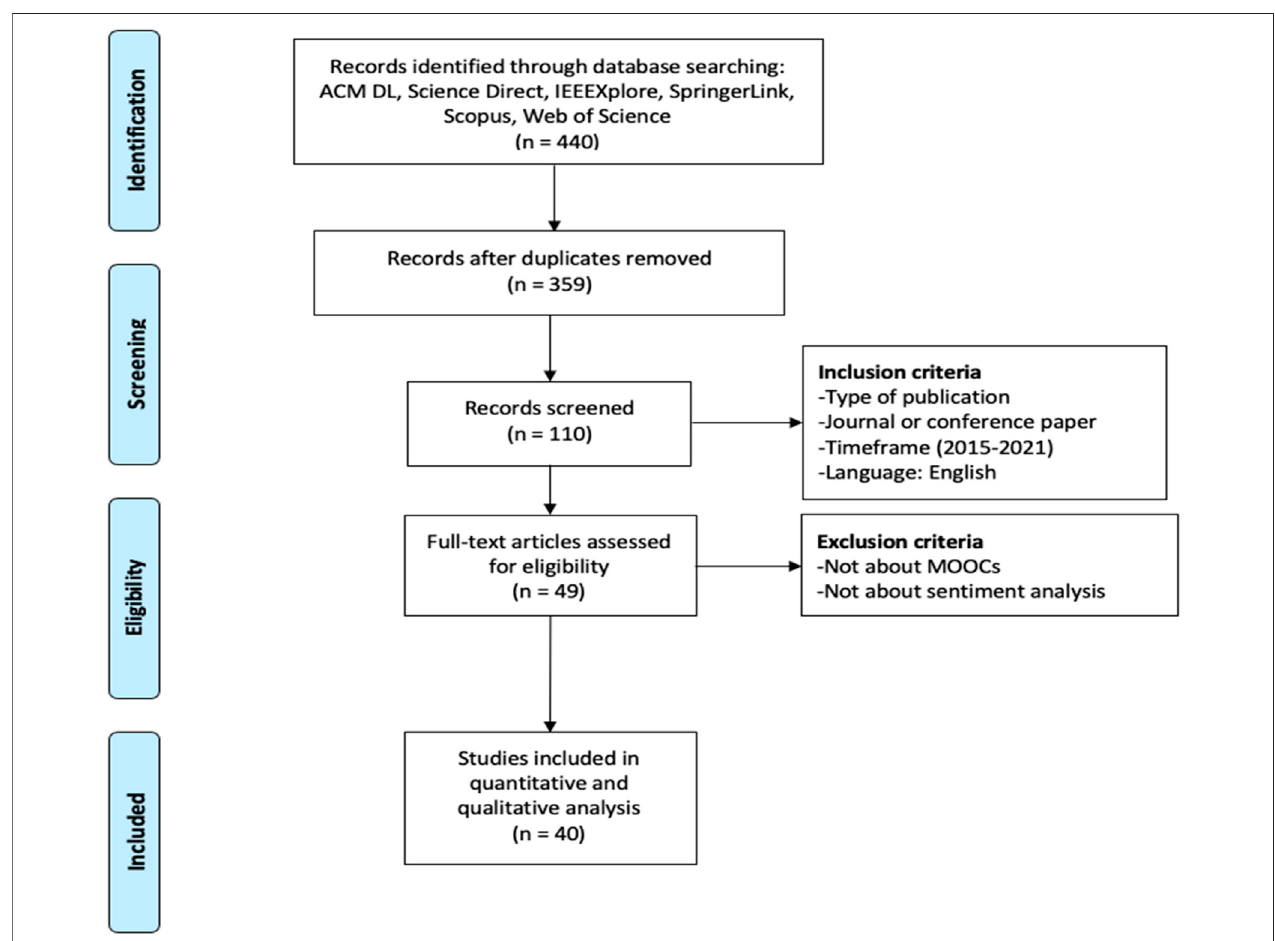
FIGURE 1 | Implemented PRISMA search methodology.